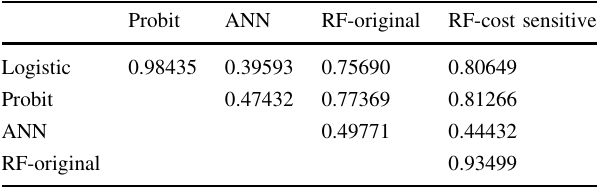
Table 4 Spearman correlation coefficient of the wildfire ignition susceptibility spatial pattern